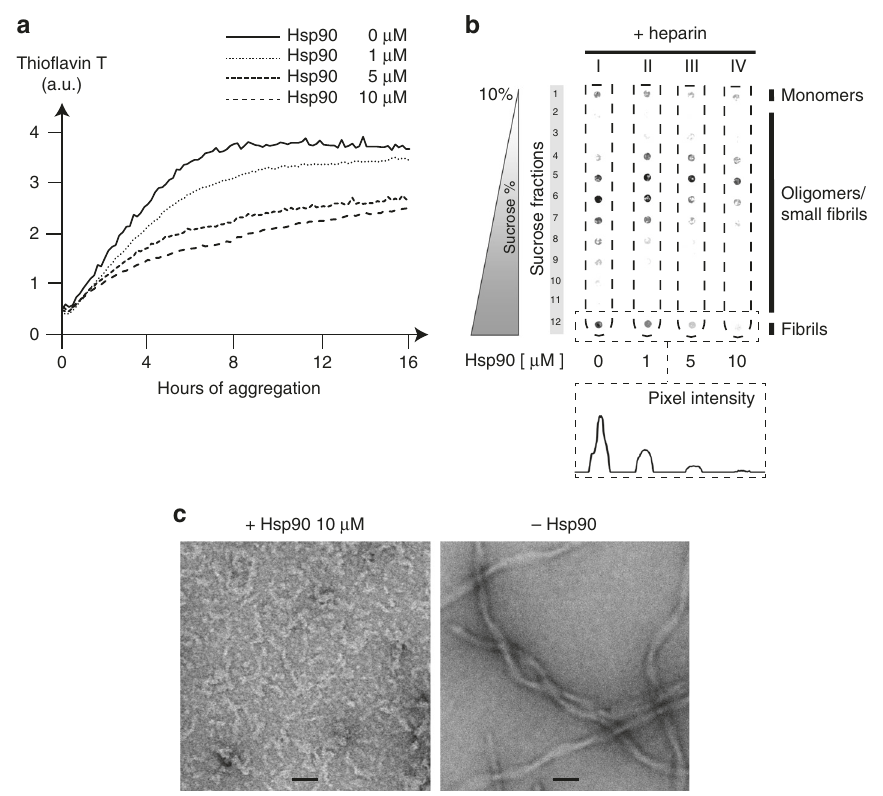
Fig. 5 Hsp90 derails Tau aggregation toward non- fi brillar nano-aggregates. a Thio fl avin T assay to detect decrease of amyloid content in the presence of increasing concentrations of Hsp90 (0, 1, 5, 10 μ M). Fluorescence is expressed as arbitrary unit (a.u.). b Density gradients to detect inhibition of fi bril formation in the presence of increasing concentrations of Hsp90 (0, 1, 5, 10 μ M). Samples from a at 16 h were loaded directly onto density gradients and resolved by centrifugation for 2.5 h at 200,000× g . Inset shows quanti fi cation of the fi bril-containing fraction for each sample. c Transmission electron microscopy of Tau-RD* aggregating samples in the presence or absence of 10 μ M Hsp90 after 2 days of aggregation. Scale bar 50